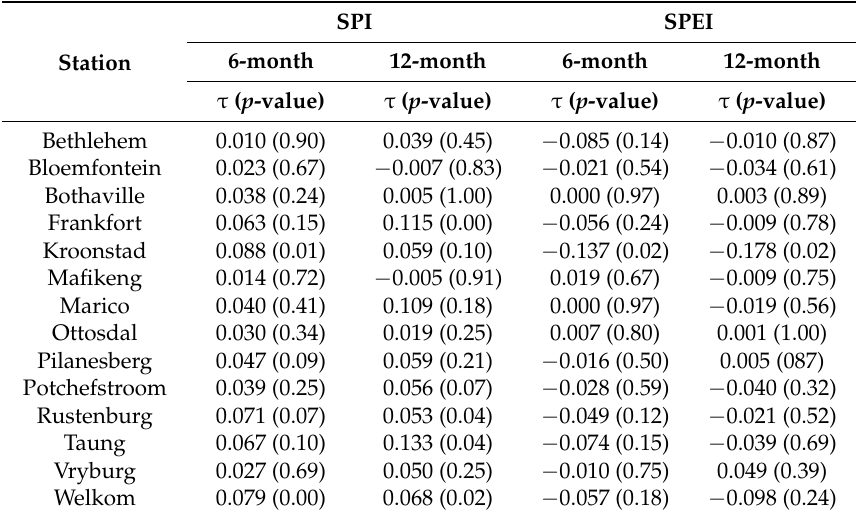
Table 5. Trends in drought severity of SPI/SPEI ‐ 6/12 across the selected weather stations.